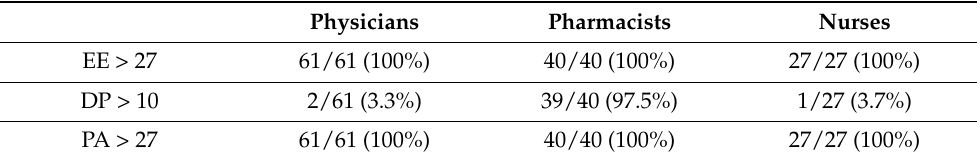
Table 4. Prevalence of burnout in physicians, pharmacists and nurses during the COVID-19 pandemic in domains of the MBI-HSS-MP: emotional exhaustion (EE), depersonalization (DP) and personal accomplishment